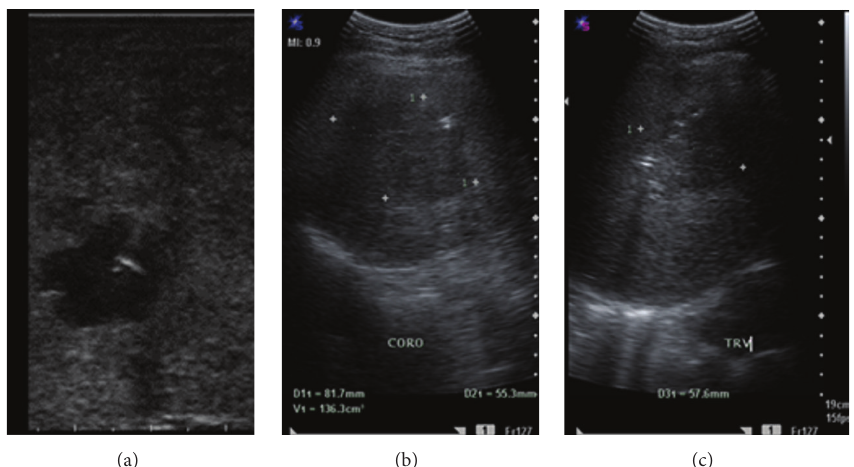
Figure 2: (a) Laparoscopic ultrasound showing the placement of a pigtail catheter to the liver abscess located at segment 8. ((b) and (c)) Third day’s postoperative ultrasound showing decrease in the amount of abscess from 162 cc to